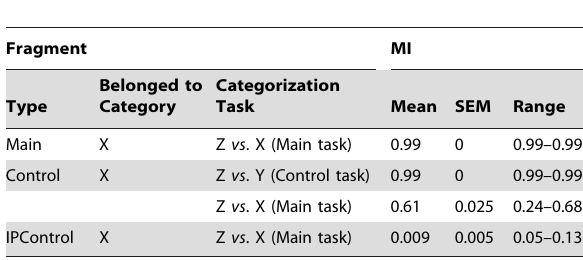
Table 2. Mutual Information of Individual Fragments in Experiment 2.